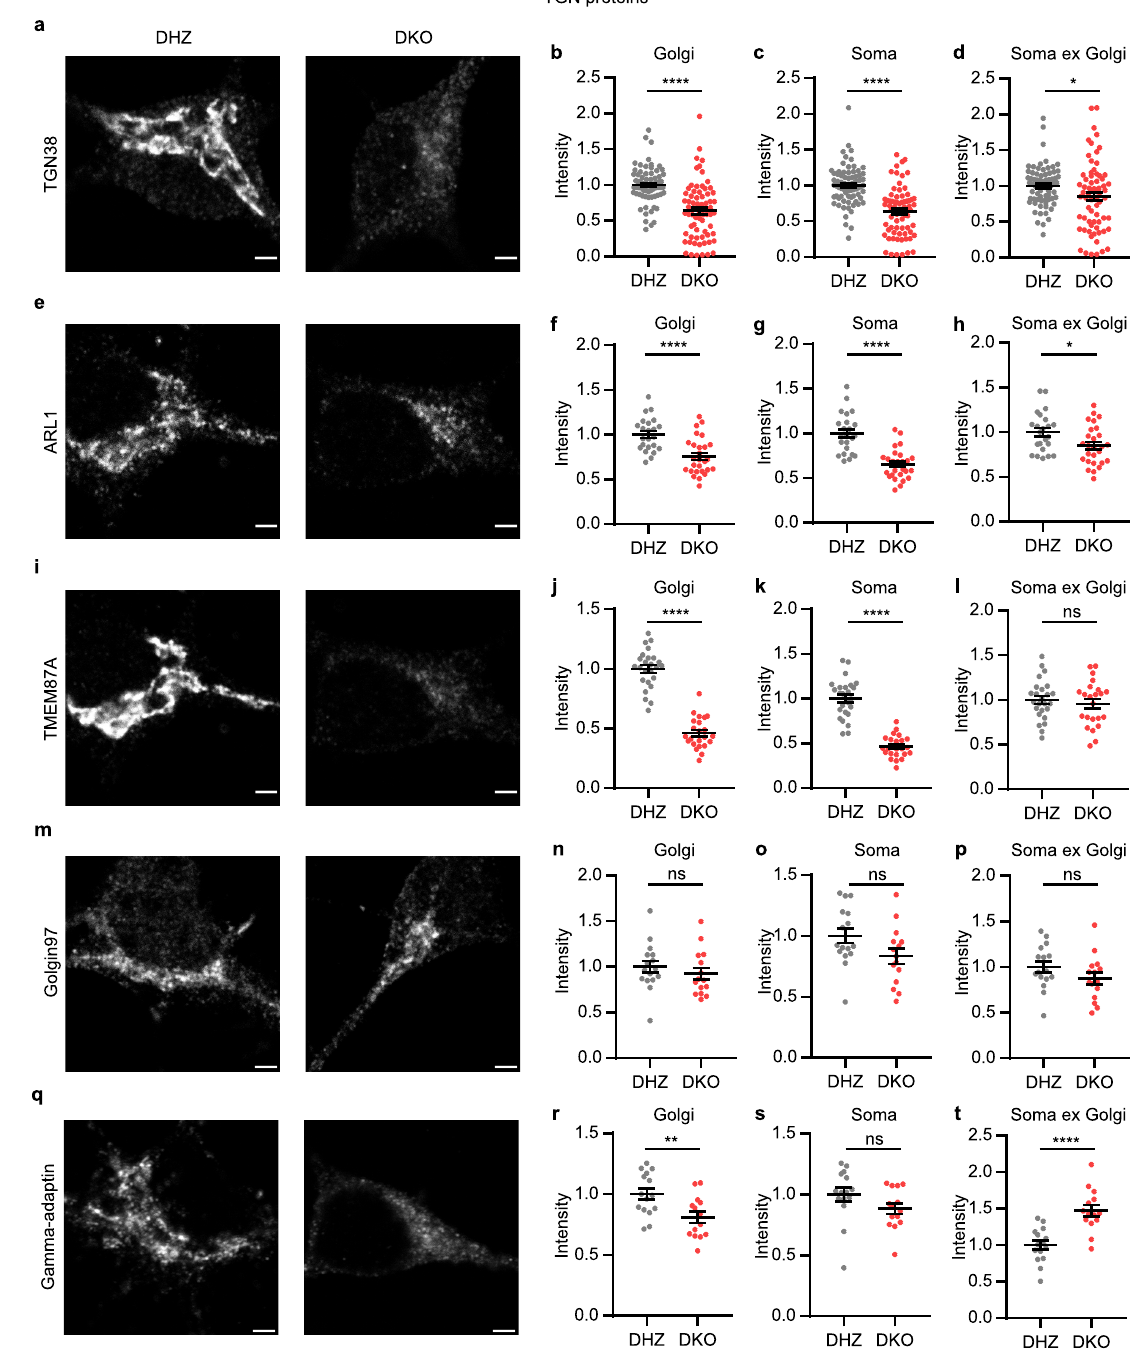
Figure 2. Staining intensity of TGN proteins is decreased or not affected in Vti1a/b deficient neurons. ( a ) Representative examples of neurons immunostained for TGN38. ( b – d ) TGN38 normalized staining intensity is decreased in the Golgi (Mann Whitney test: ****p < 0.0001) ( b ), soma (Mann Whitney test: ****p < 0.0001) ( c ), and soma excluding Golgi (Mann Whitney test: *p = 0.0145) ( d ) (DHZ: n = 73; DKO: n = 69). ( e ) Representative examples of neurons immunostained for ARL1. ( f–h ) ARL1